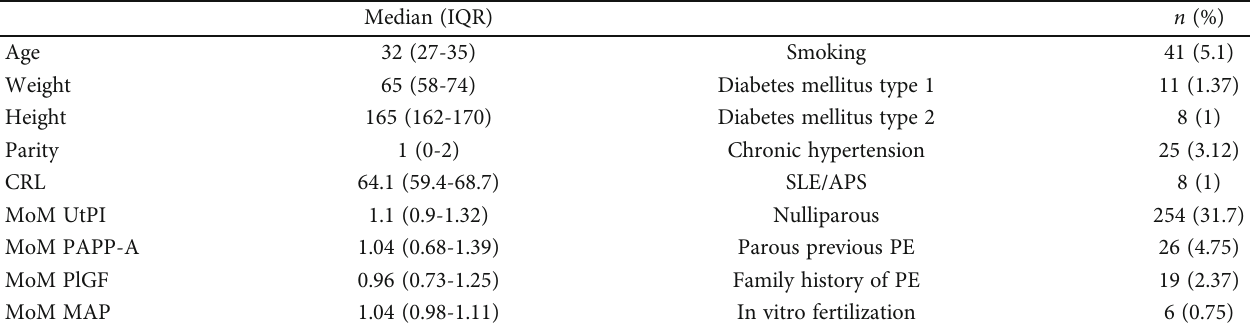
Table 1: Characteristics of the study group (CRL: crown rump length; SLE: systemic lupus erythematosus; APS: Antiphospholipid